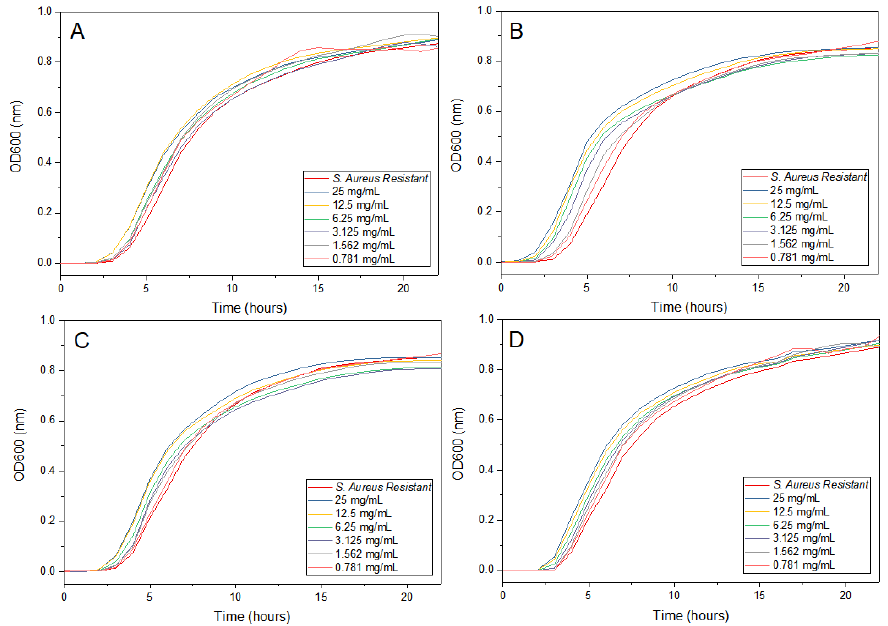
Figure 10. Antimicrobial activity of citrus peels extracts at different times. ( A ) Lemon peel extract. ( B ) Orange peel extract. ( C ) Grapefruit peel extract. ( D ) Mixture of lemon, orange, and grapefruit extracts.